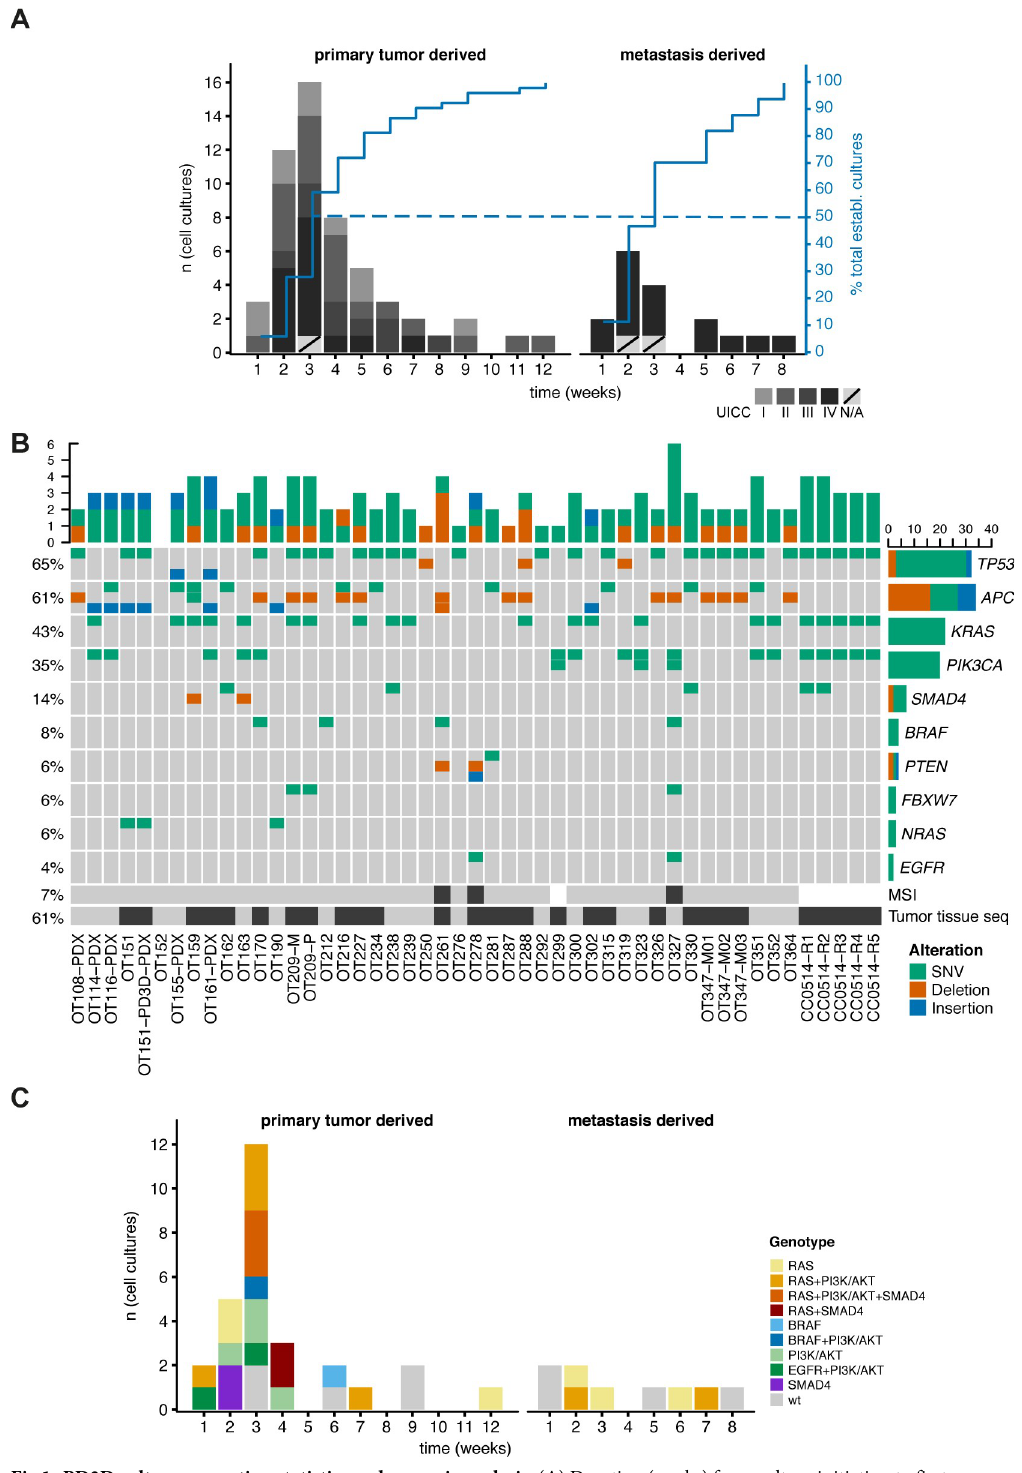
Fig 1. PD3D culture generation statistics and genomic analysis. ( A ) Duration (weeks) from culture initiation to first passage (primary tumors n = 54; metastatic tumors n = 17). UICC stages are indicated in the grey scale; metastases are generally considered as stage IV. ( B ) Mutation of key genes affected in CRC found via cancer gene panel sequencing in 49 patient- derived three-dimensional (PD3D) cultures and 29 matched original tumor samples (indicated with a black box at the bottom). The percentage of organoid cultures harboring a mutation in a given gene is shown on the left side, the